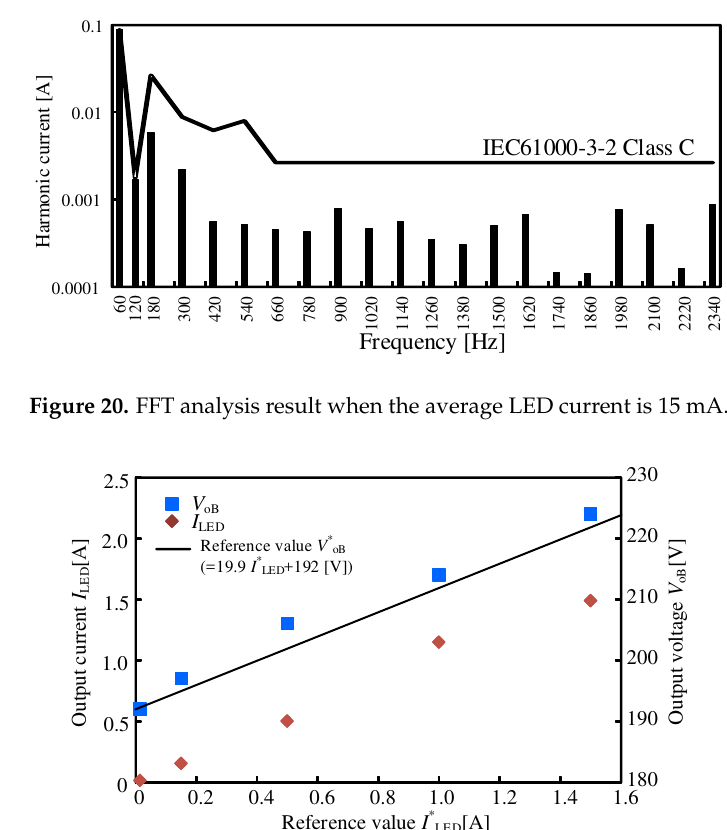
Figure 19. FFT analysis result when the average LED current is 1.5 A.